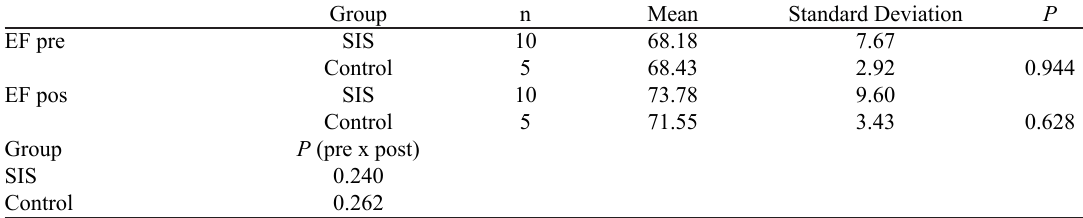
Table 2. Inter- and intra-group left ventricular ejection fraction (EF) analysis (%) between pre-operative evaluation and 60 days after surgery.